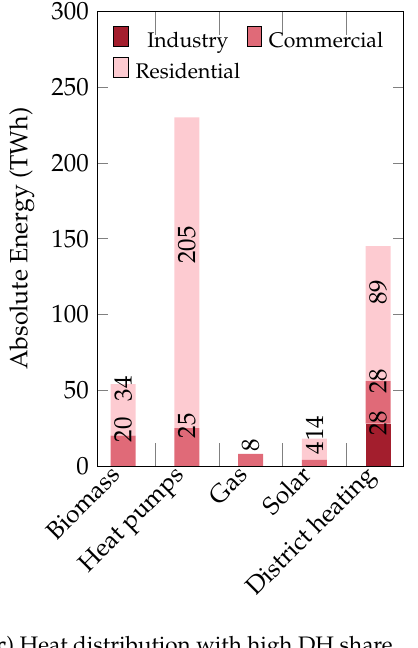
Figure 9. Static energy demand and heating distribution.